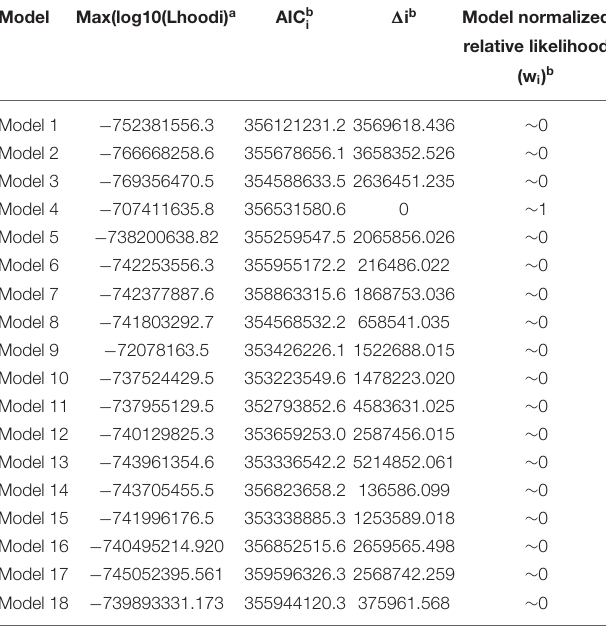
TABLE 2 | Relative likelihood of the different models. TABLE 3 | Demographic parameters and confidence interval of the best